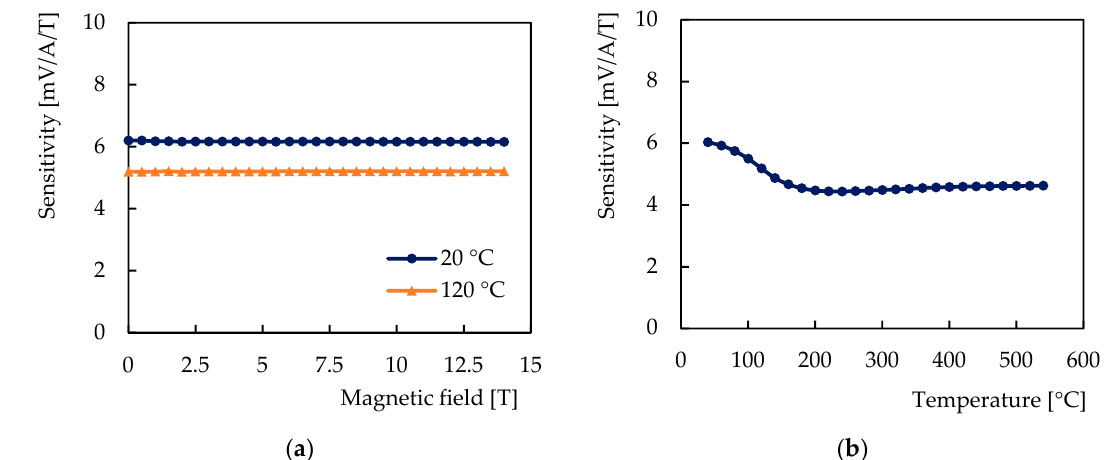
Figure 6. Sensitivity of the tested sensor with chromium sensitive nanolayer: ( a ) Dependence on the magnetic field at 20 °C and at 120 °C; ( b ) Dependence on the temperature in the magnetic field of 200 mT.